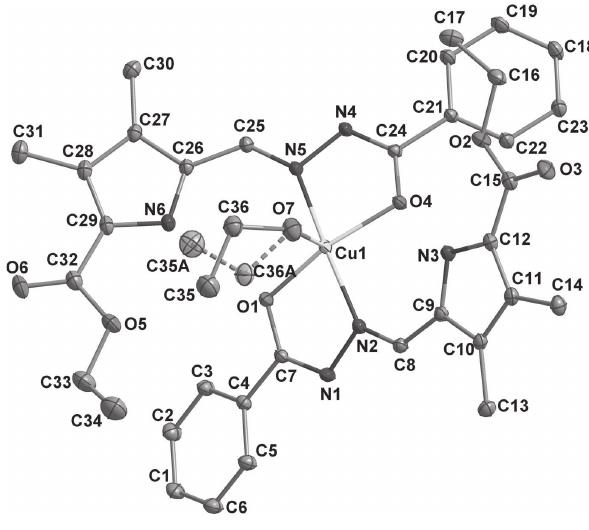
Table 1: Data collection and handling.